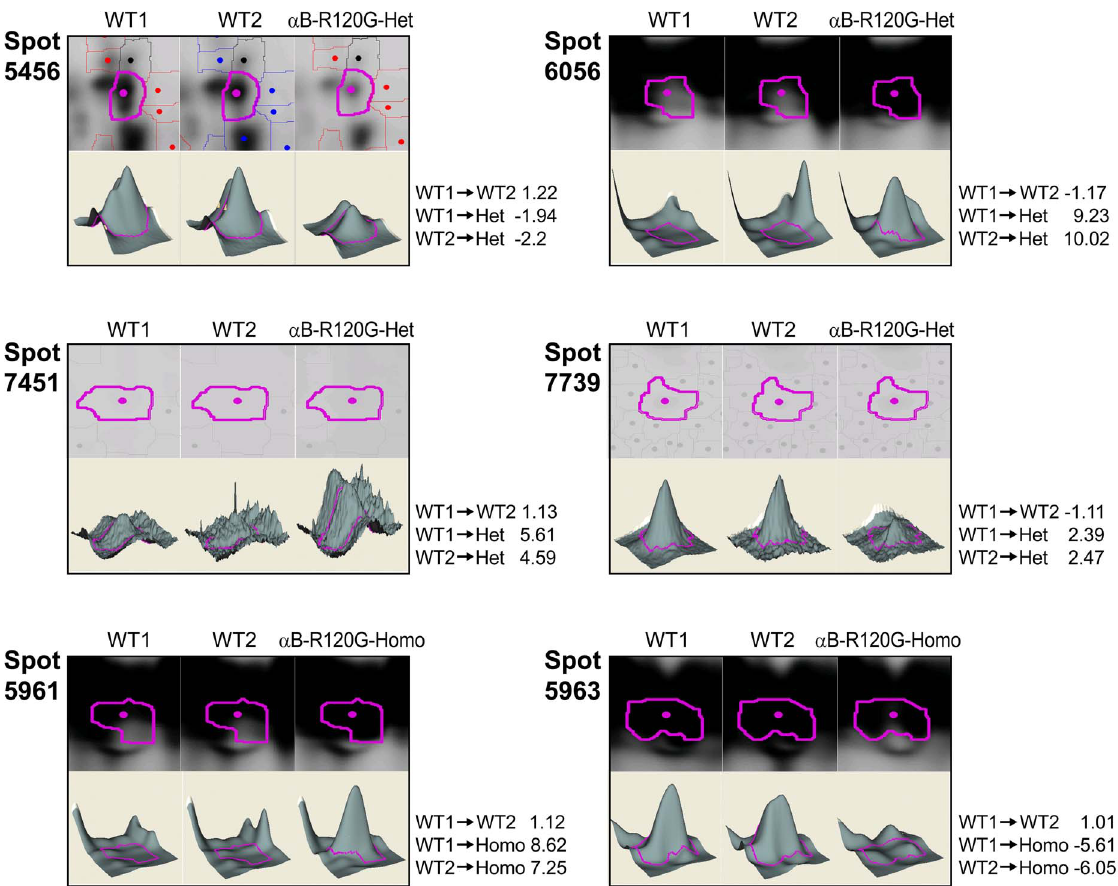
Figure 7. Quantitative analysis of the changes in abundance of proteins in postnatal 14-day-old lens from WT and a B-R120G knock- in mice by mass spectrometry. The 3D data sets for representative proteins in two WT (WT1 and WT2) and one a B-R120G mutant sample are shown. (A) WT1 and WT2 proteins were labeled with Cy3 and Cy5 dyes, respectively, and a B-R120G heterozygous mutant lenses with Cy2. (B) WT1 and WT2 proteins were labeled with Cy2 and Cy3 dyes, respectively, and a B-R120G homozygous mutant lenses with Cy5. Fold changes between each sample are indicated on the right. See Table 4 for the identity of proteins present in each protein spot.